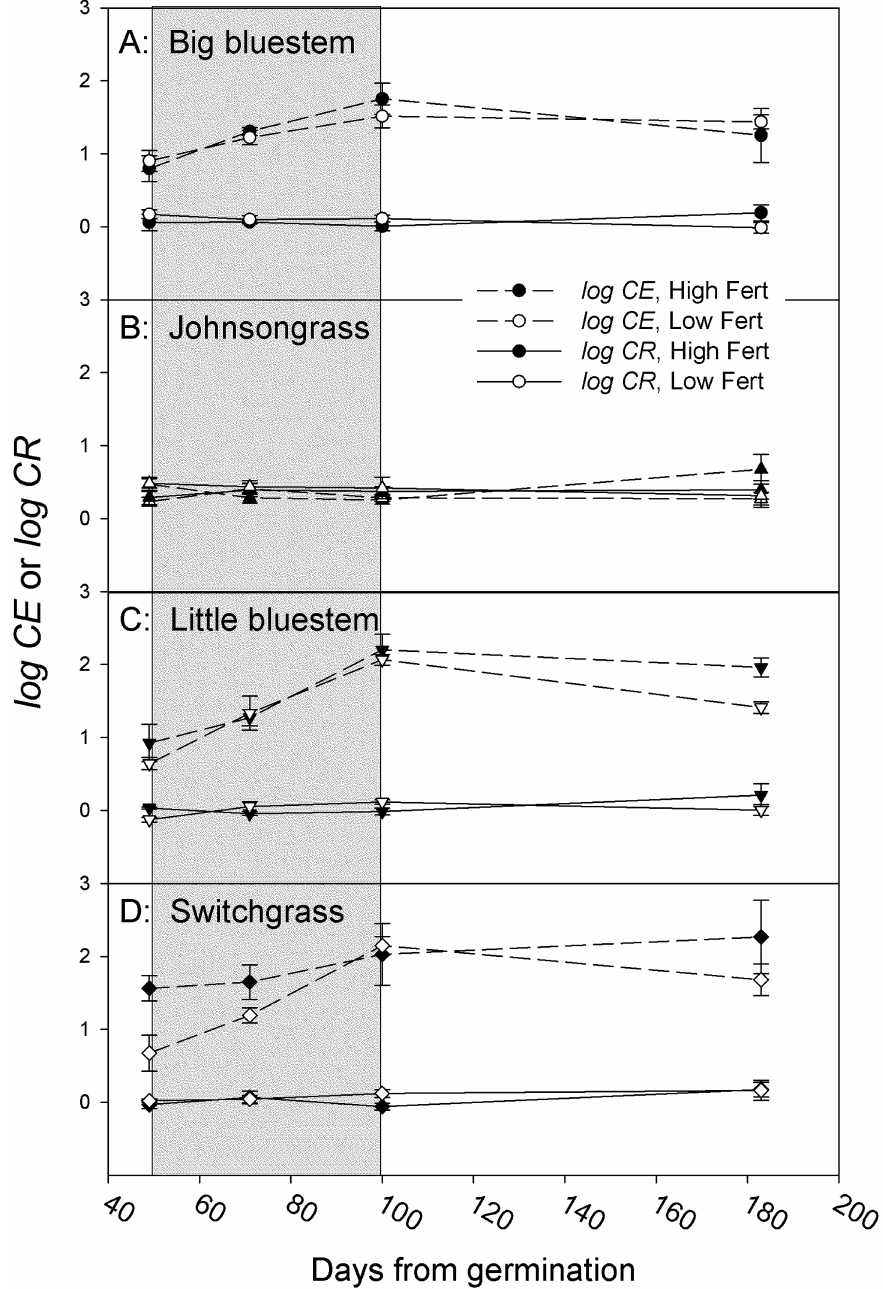
Fig 2. Competitive effects( log CE , dashed lines) and responses ( log CR , solid lines) of Johnsongrass. Positive values indicatereducednon-rootbiomass relative to single plants. Solid symbols for high fertilizer, open symbols for low fertilizer. The shadedarea indicatesthe periodover which water was withheld.Error bars reflect one standarderror of the mean. 9%. The competitive effect of Johnsongrass on the native species subsequently increased dur- ing the drought period (harvest date p < 0.001, Fig 2A, 2C and 2D) and became maximal at the end of the drought period. At final harvest, the non-root biomass relative to single plants was 5% for big bluestem and 2% for both little bluestem and switchgrass. Across harvest date